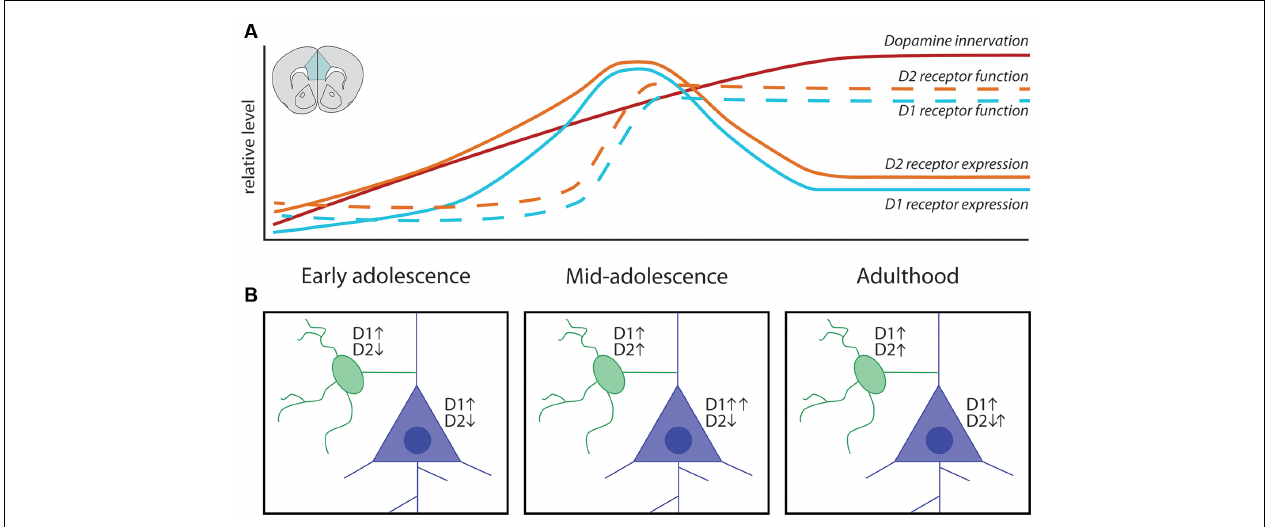
FIGURE 3 | Adolescent maturation of dopamine connectivity and function in the prefrontal cortex. (A) Summary of maturational changes in DA connectivity in the PFC across adolescence. (B) Early in adolescence DA signaling through D1 receptors is excitatory onto both classes of neurons, with DA signaling through D2 receptors inhibiting pyramidal neurons and weakly inhibiting GABAergic interneurons. In mid-adolescence DA signaling through D2 receptors becomes excitatory onto GABAergic interneurons. DA signaling through D1 receptors is now able to interact with glutamatergic NMDA receptors on pyramidal neurons, increasing the activating effect of DA. In adulthood D1 and D2 receptor populations attain their mature function.